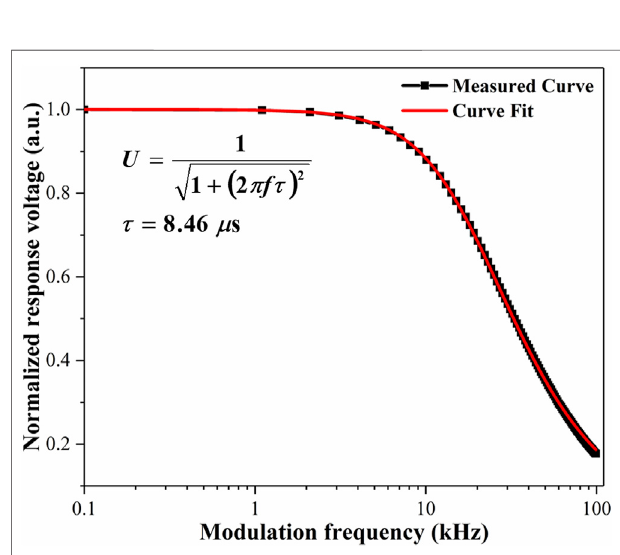
FIGURE 8 | Normalized response voltage of the Nb 5 N 6 microbolometer THz detector as a function of modulation frequency for the determination of the thermal time